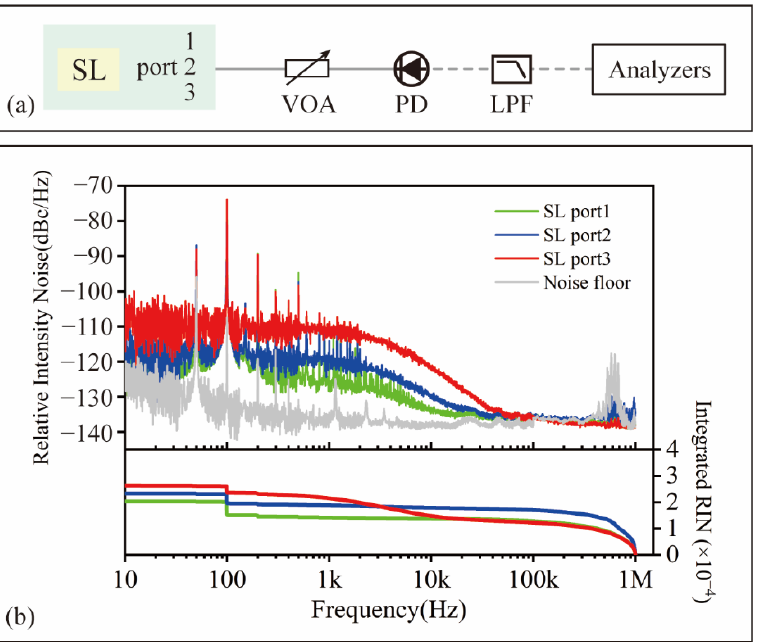
Figure 4. ( a ) Relative intensity noise measurement setup; ( b ) relative intensity noise power spectral density of the optical pulses from signal laser outputs.